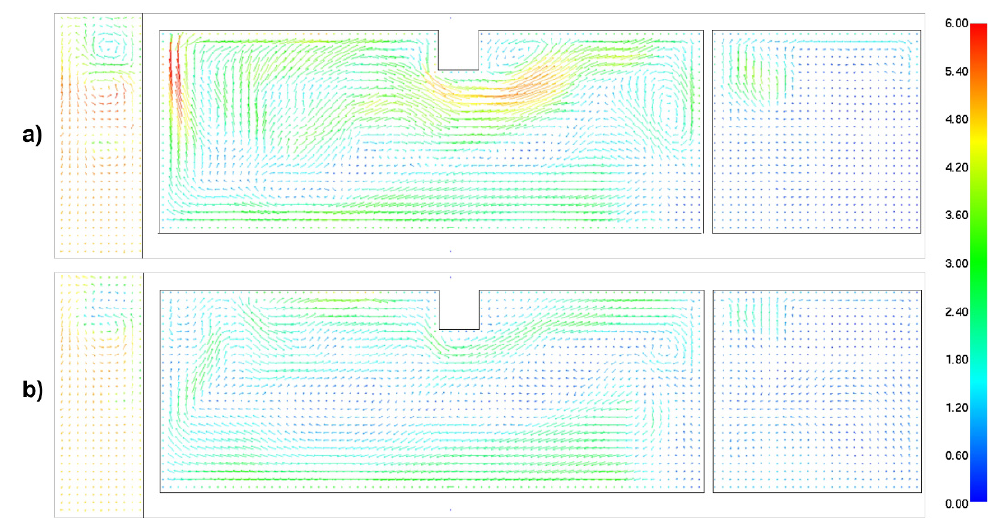
Figure 12. Velocity vectors fields on section 4.6 Y – a) 300 and b) 1140 seconds.